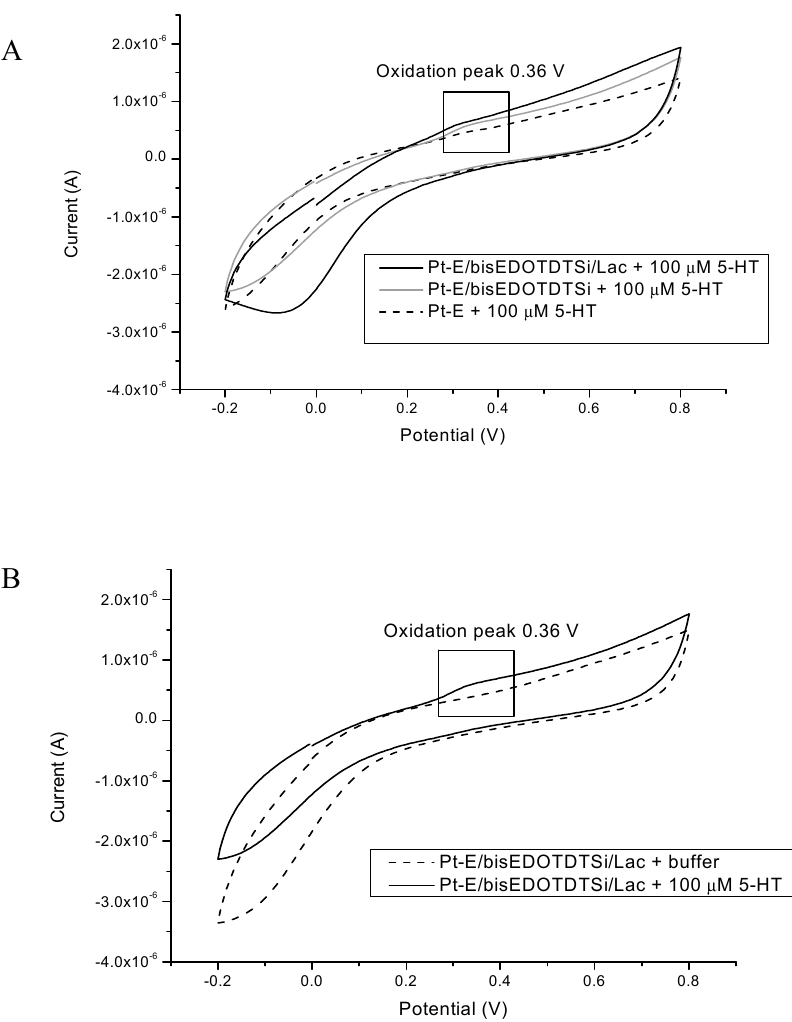
Figure 9. ( A ) Representative cyclic voltammetry (CV) scans of the bare Pt electrode (1), Pt electrode modified with bisEDOTDTSi (2), and Pt-E/bisEDOTDTSi/Lac (3) system in the presence of 5-HT (100 μ M) under an applied potential in the range of − 0.2 to 0.8 V, scan rate 50 mV/s, versus Ag/AgCl (0.1 M). ( B ) Detection system for Pt-E/bisEDOTDTSi/Lac with and without the investigated sample (5-HT).